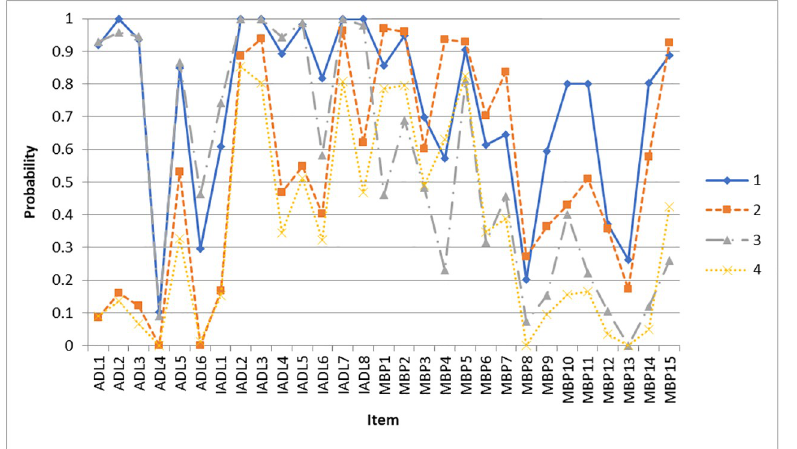
Fig 1. Conditional probability of class based on PWD symptoms (answer = yes).